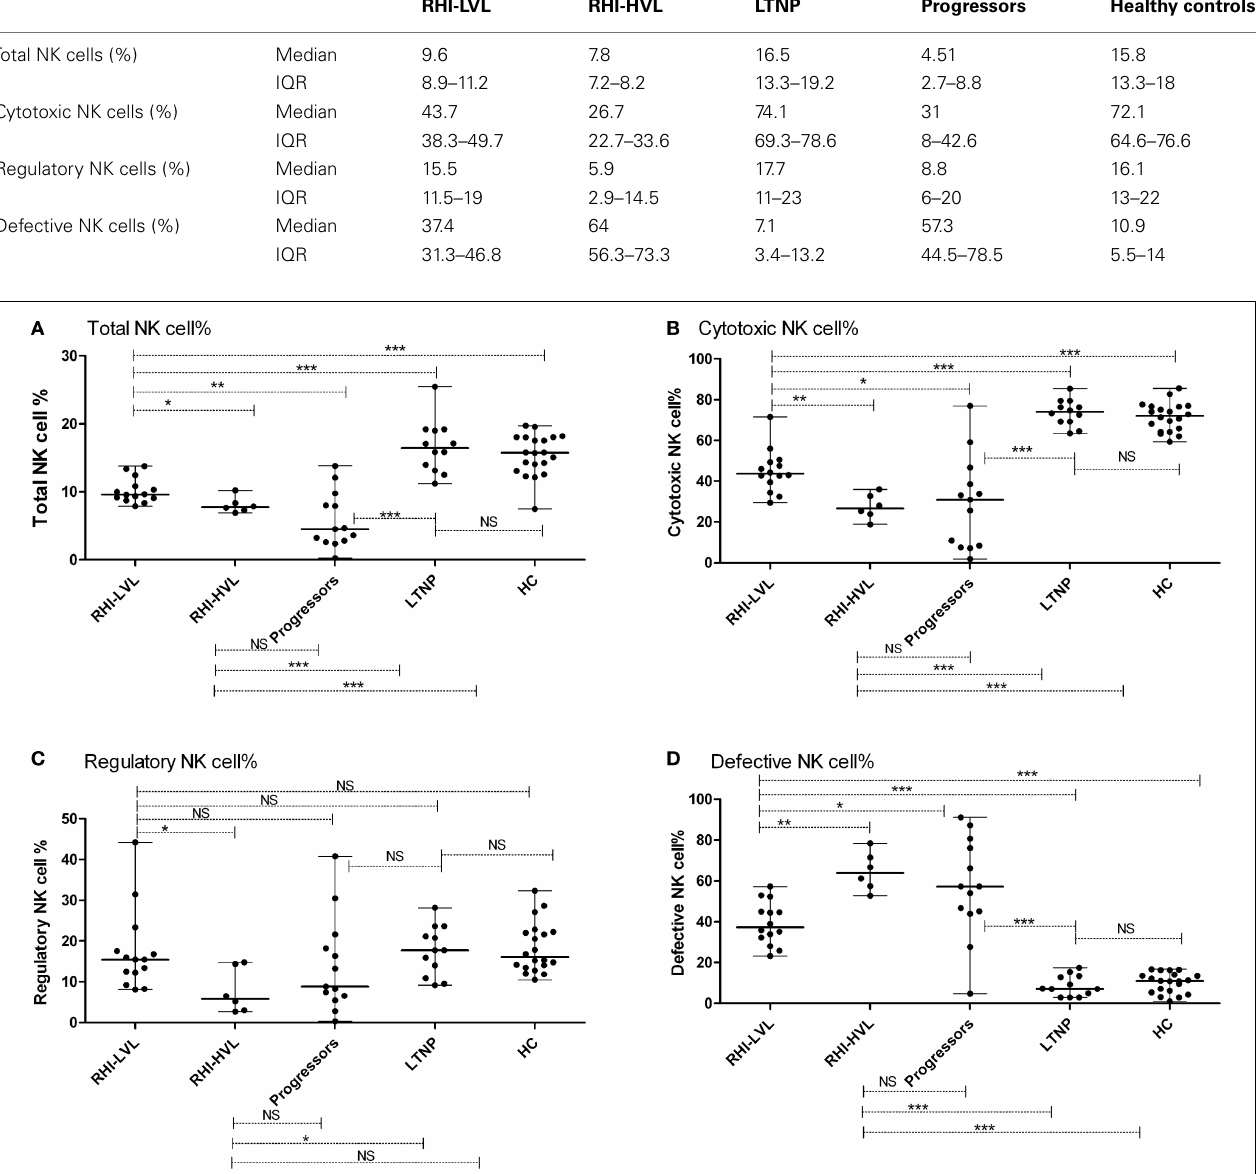
FIGURE 3 |Total NK cell frequency and subset wise distribution in study participants . (A) Total NK cell %, (B) cytotoxic NK cell %, (C) regulatory NK cell %, and (D) defective NK cell %. * p < 0.05, ** p < 0.01, *** p < 0.001, and NS, not